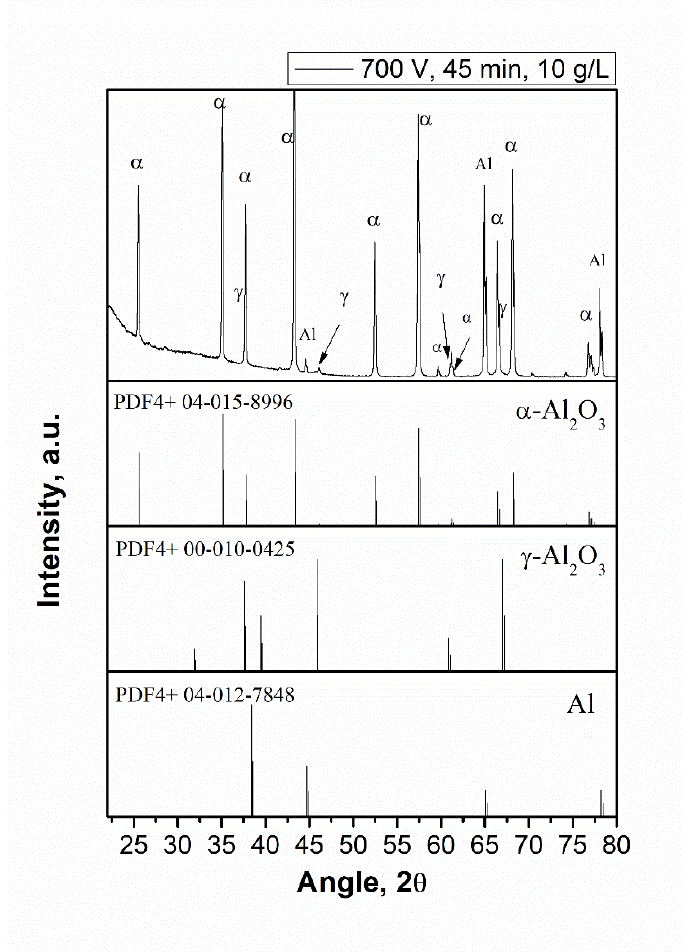
Figure 2. XRD measurement of the sample coating produced with PEO parameters 700 V, 45 min process duration and 10 g·L −1 citric acid concentration with all major peaks marked with the corresponding phase.